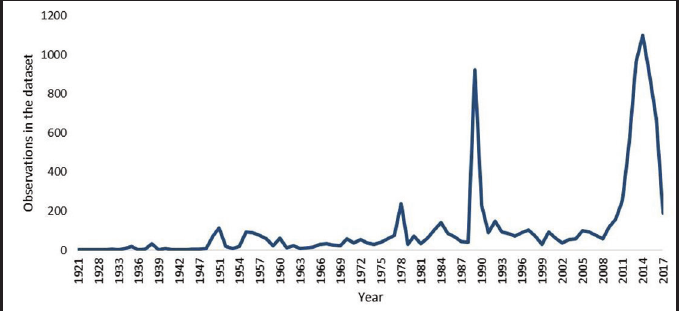
Born abroad by year of arrival to